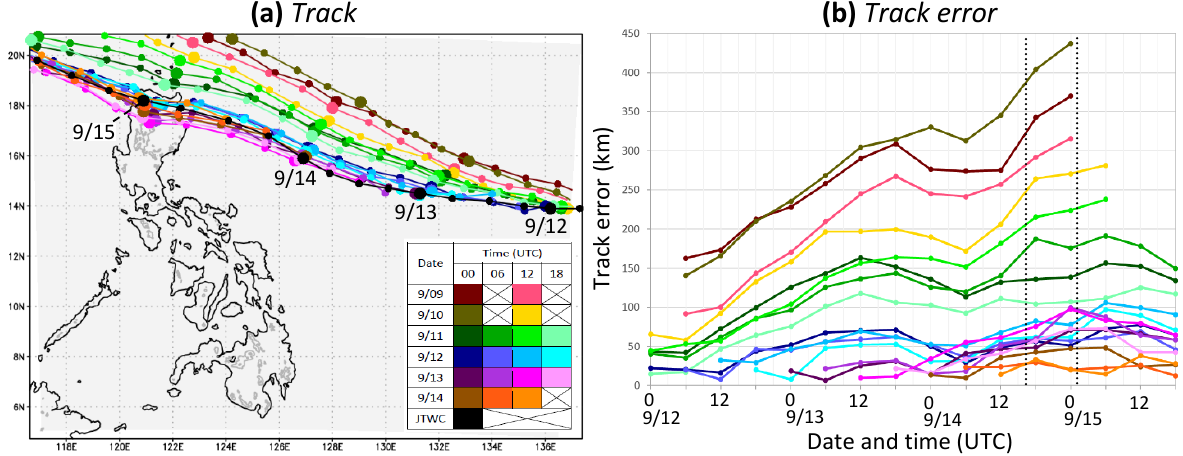
Figure 2. ( a ) The JTWC best track (black) and predicted tracks (colors) of TY Mangkhut (2018) by the time-lagged forecasts at different initial times (see insert), and ( b ) the track errors against time from 0000 UTC 12 to 1800 UTC 15 September, with the two dotted vertical lines indicating the landfall period based on the JTWC best track.